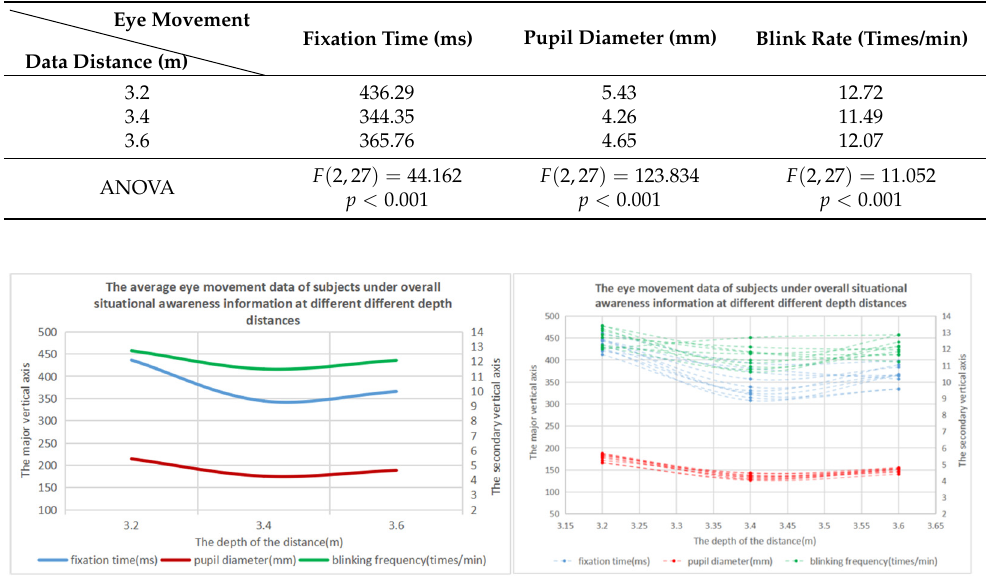
Table 9. The average eye movement data after dividing the overall situational awareness information depth and distance range.